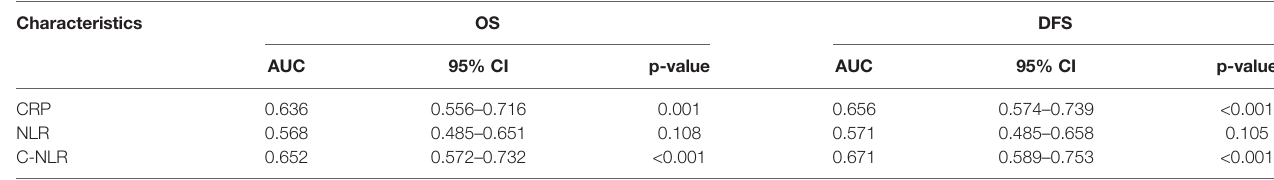
TABLE 4 | The AUCs of CRP, NLR, and C-NLR for OS and DFS prediction based on the ROC results. Characteristics